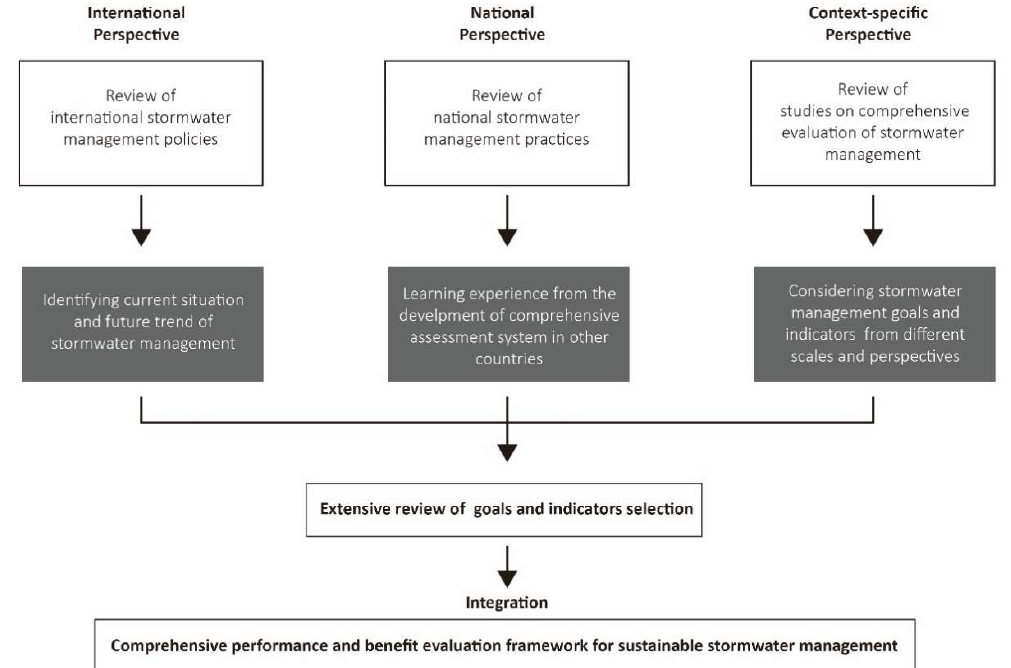
Figure 2. The structure of developing the comprehensive evaluation framework for sustainable stormwater management (SSWM).